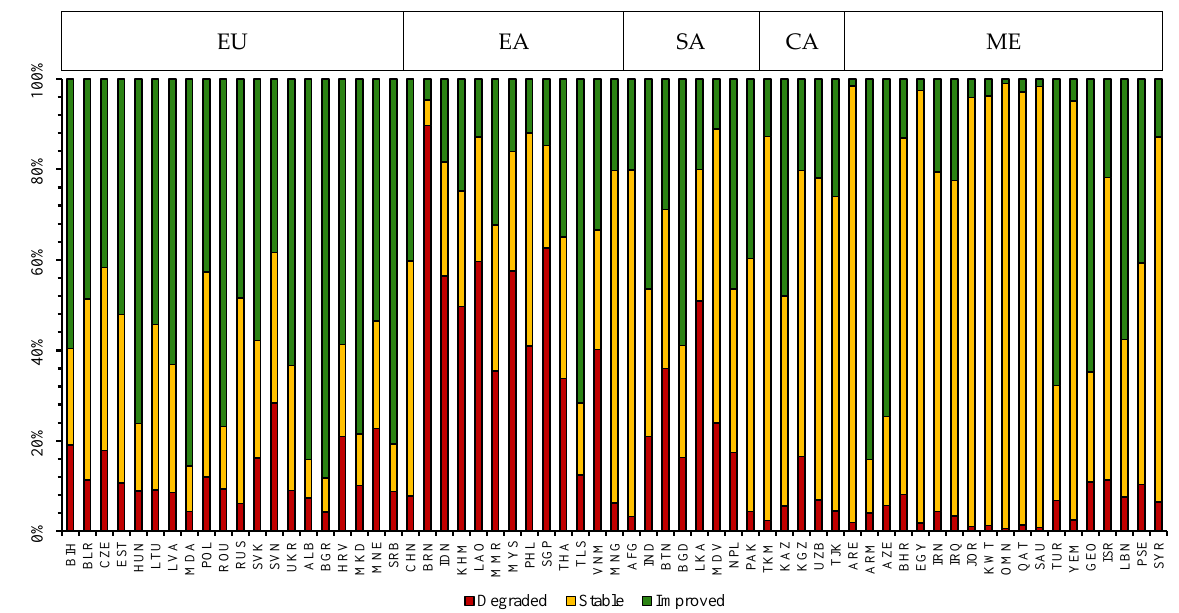
Figure 6. Percentage of ecological change trends in 65 countries in the Pan-Third Pole region from 2000 to 2020.